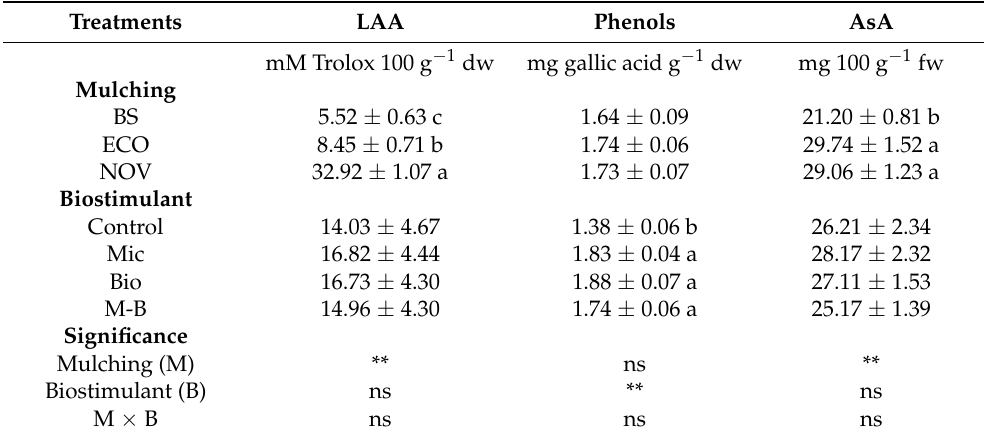
Table 4. Tomato plant lipophilic antioxidant activity (LAA), phenols, and total ascorbic acid content (AsA) at harvest in relation to mulching biofilms and biostimulant